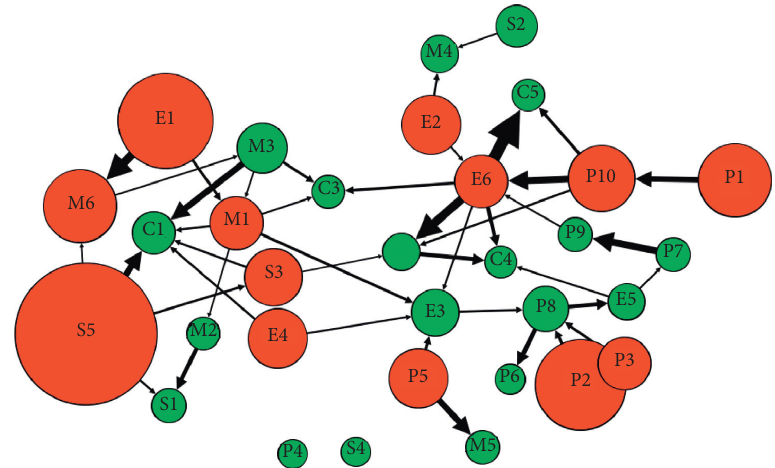
Figure 3: Accident network of metro